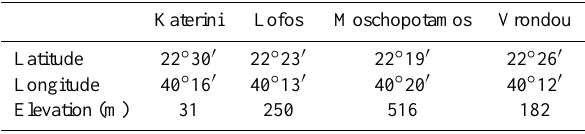
Table 1. Location of the stations considered for drought analysis.